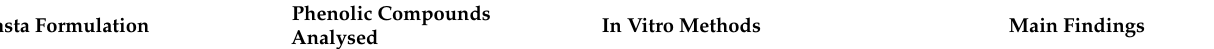
Table 3. Bioaccessibility studies on phenolic compounds in